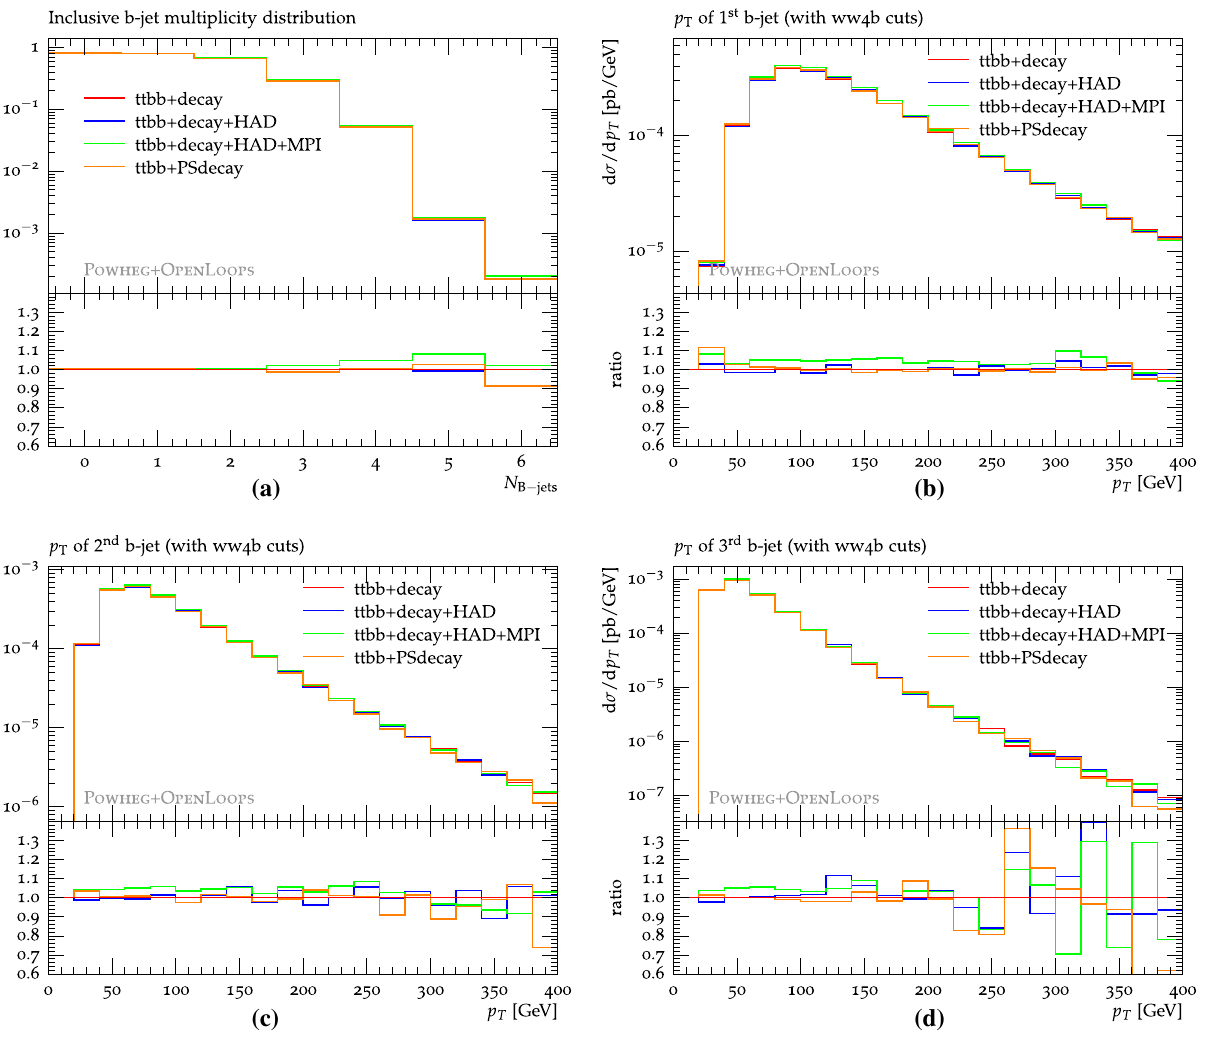
√ Powheg+Pythia , and in the lower frame nominal NLOPS predictions Fig. 14 Predictions for pp → t ¯ t + b -jets at s =13TeV after leptonic with spin-correlated decays without (ttbb + decay) and with hadronisa- top-quark decays. Four b -jets and two leptons within acceptance are tion (ttbb + decay + HAD) and multi-parton interactions (ttbb + decay + required without any distinction between b -jets from t ¯ tb ¯ b production HAD + MPI) are compared to corresponding ones with Pythia decays and decay. Distributions in the inclusive number of b -jets ( a ) and in the p T of the first ( b ), second ( c ) and third ( d ) b -jet. All results are based on (ttbb +